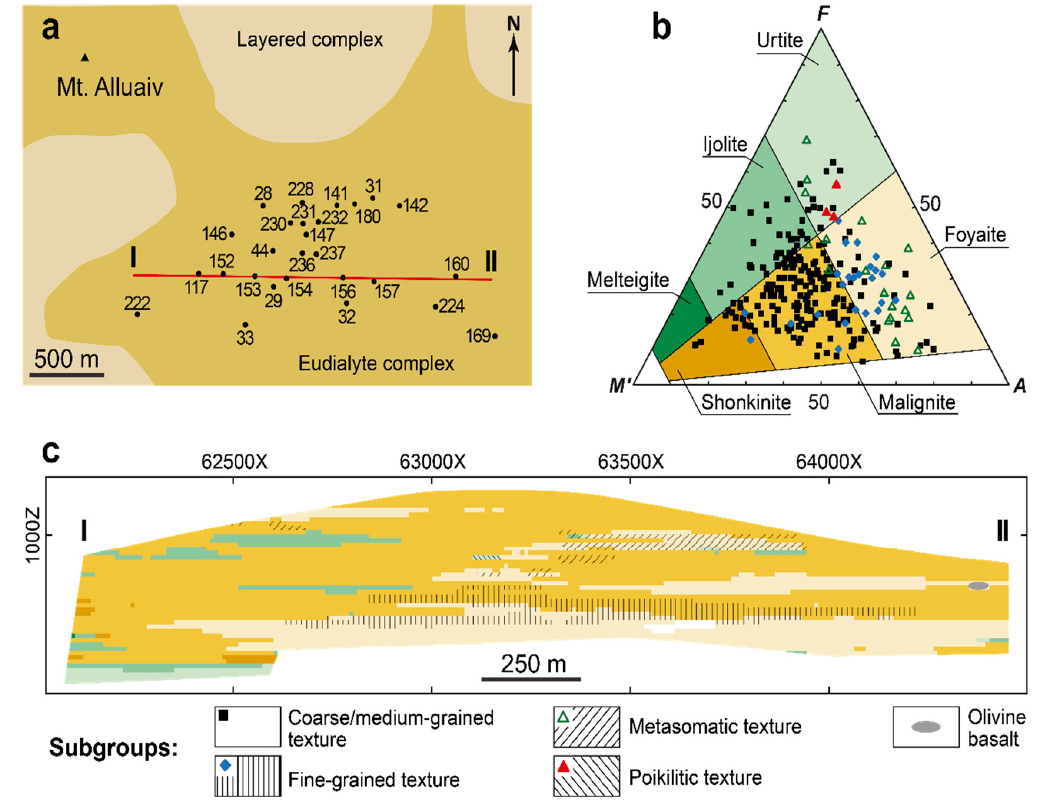
Figure 2. The Alluaiv site of the Lovozero Eudialyte Deposit (see Figure 1a): ( a )—scheme of drill holes; ( b )—the modal composition of alkaline rocks of the Alluaiv site. Rocks with fine-grained (blue diamonds), metasomatic (green triangles) and poikilitic (red triangles) textures are highlighted with special icons; ( c )—section along the I–II line (see Figure 2a). The rock legend corresponds to Figure 2b. Rock with fine-grained, metasomatic, and poikilitic textures are highlighted by hatching.